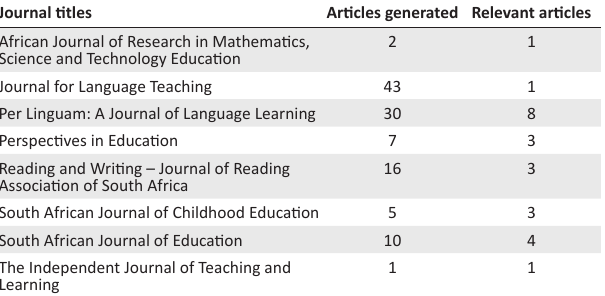
TABLE 1: Number of articles relevant to the inclusion criteria from all journal articles accessed using the keywords ‘literacy intervention’ and ‘reading